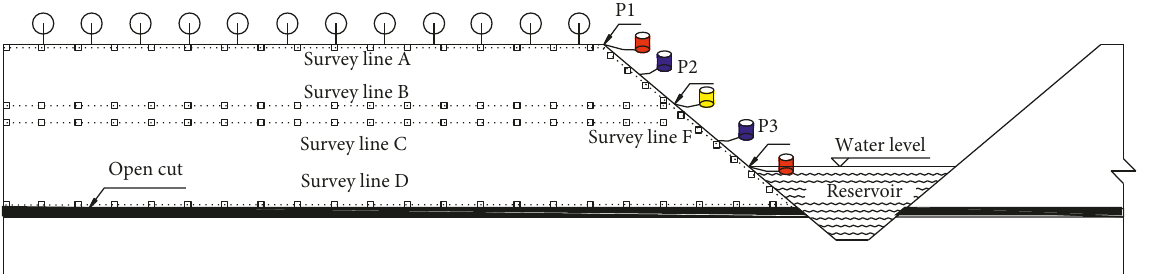
Figure 5: The similar-material physical model monitoring